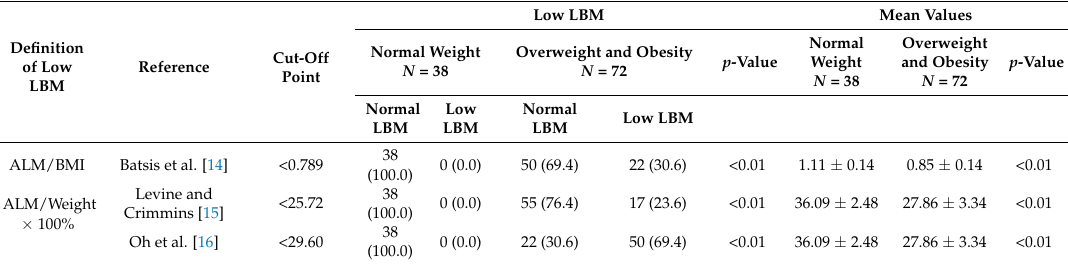
Table 2. Prevalence of reduced lean body mass (LBM) among the study participants using different definitions.